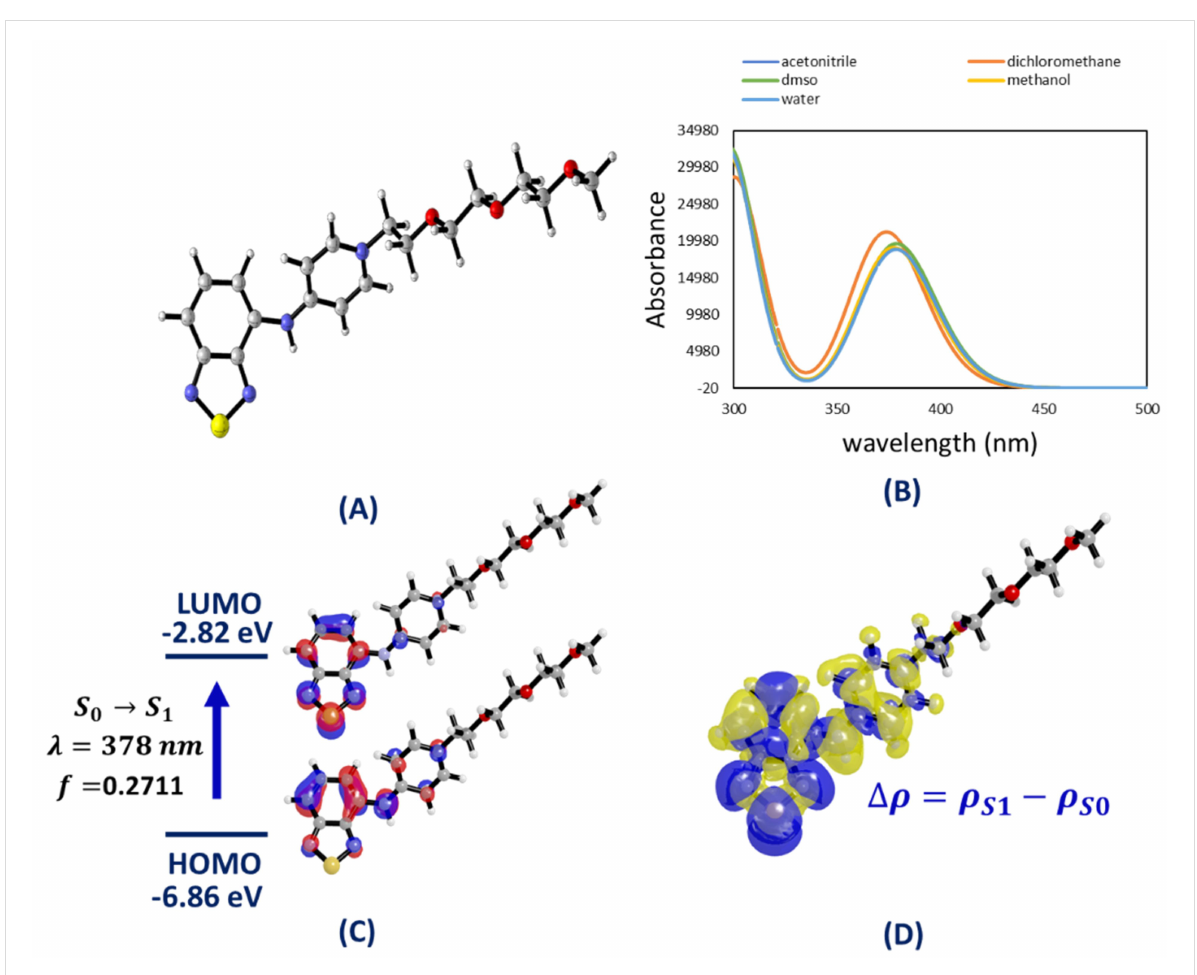
Figure 4: (A) CAM-B3LYP/6-311+G(d) optimized geometry of BTD-4APTEG (implicit DMSO). (B) TD-DFT UV–vis spectra of BTD-4APTEG calcu- lated at the PBE1PBE/6-311+G(2d,p) level of theory. Solvent effects were estimated under the IEF-PCM formalism. (C) PBE1PBE/6-311+G(2d,p)// CAM-B3LYP/6-311+G(d) HOMO and LUMO orbitals of BTD-4APTEG in DMSO involved in the S0 → S1 electronic excitation associated with the longest wavelength band. (D) Electron density difference between the first excited and ground states ( Δρ = ρ S1 – ρ S0 ), where blue regions corre- spond to density accumulation whereas the yellow means the density